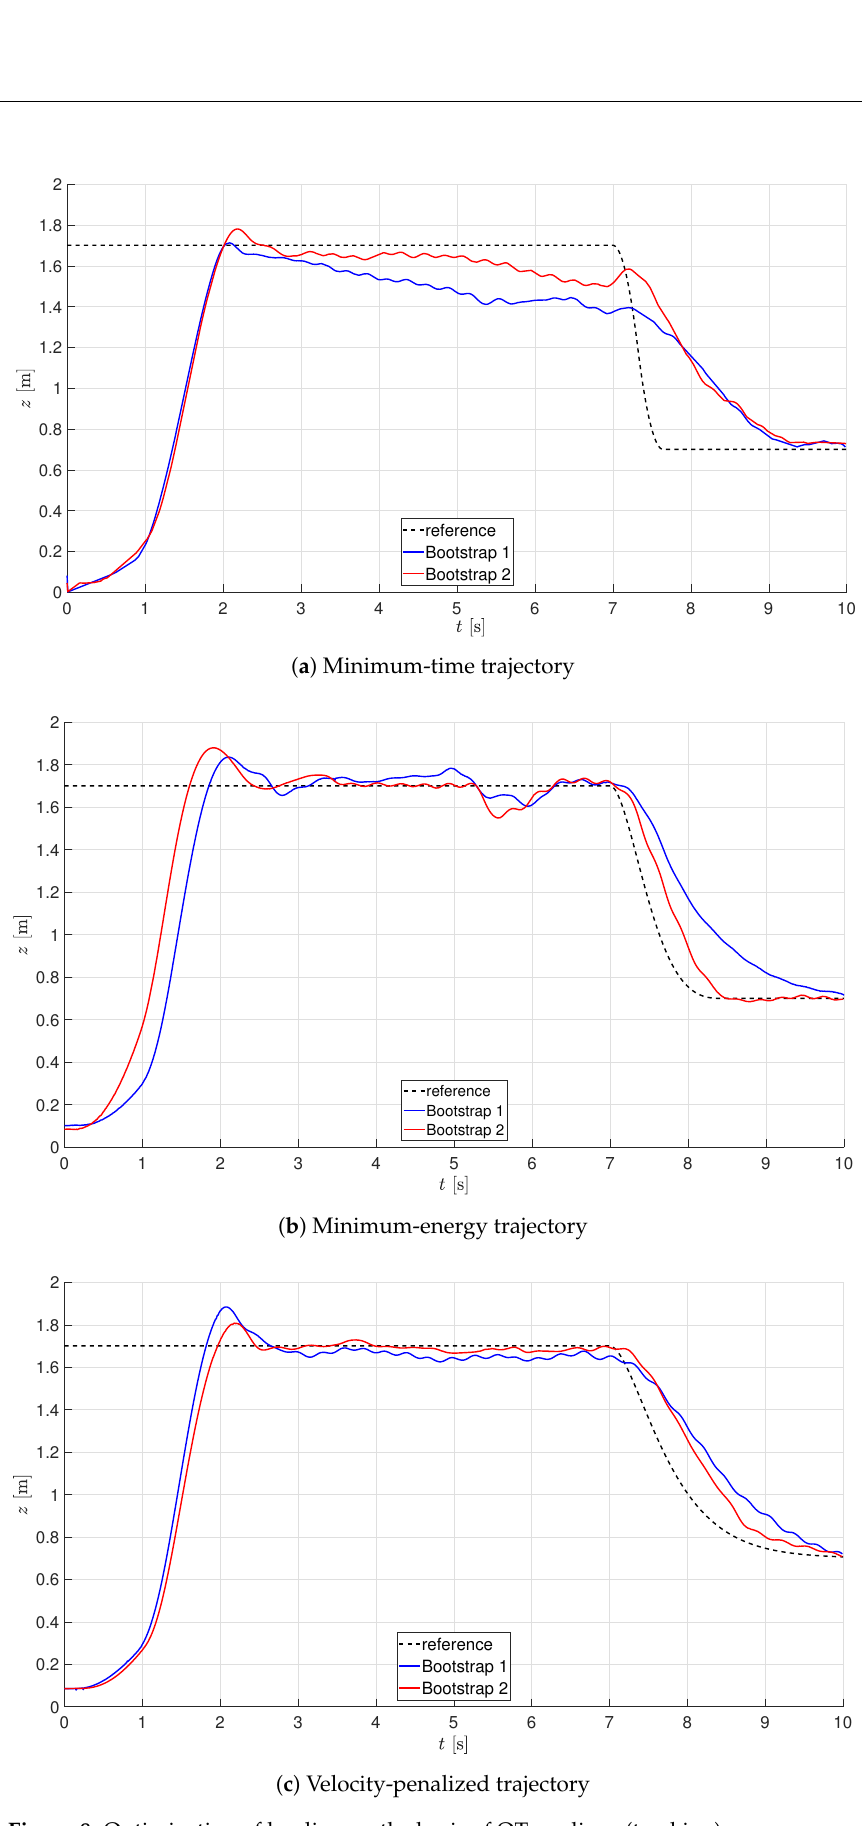
Figure 8. Optimization of landing on the basis of OT readings